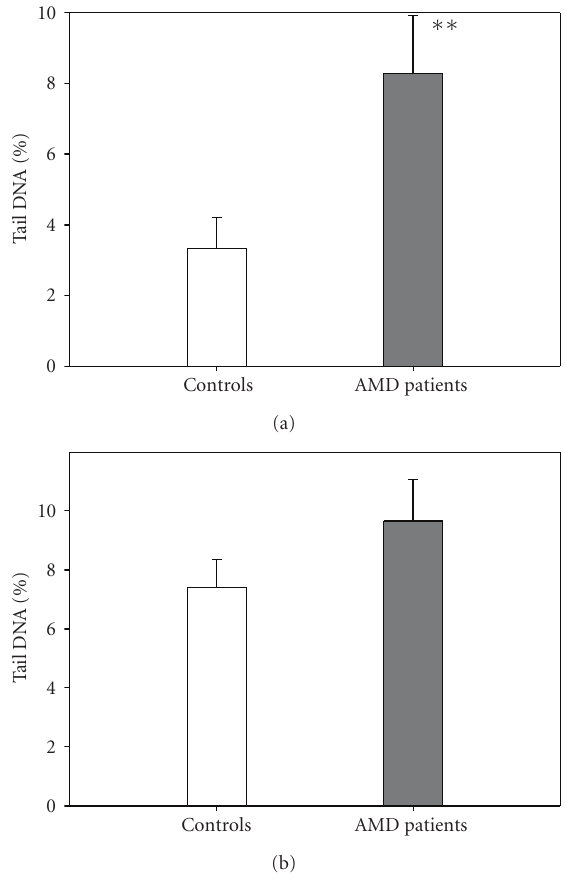
Figure 2: Oxidative DNA damage in peripheral blood lymphocytes of 30 AMD patients (grey bars) and 30 healthy controls (white bars) recognized by Nth (a) or Fpg (b) at 1 μ g/mL in the alkaline comet assay. Each bar is a mean di ff erence between Fpg or Nth treated cells and enzyme-nontreated controls. DNA damage was measured as the percentage of DNA in the tail in the alkaline comet assay. The number of cells scored for each individual was 100. The results displayed are the mean of three independent experiments ± S.E.M. ∗∗ P < .